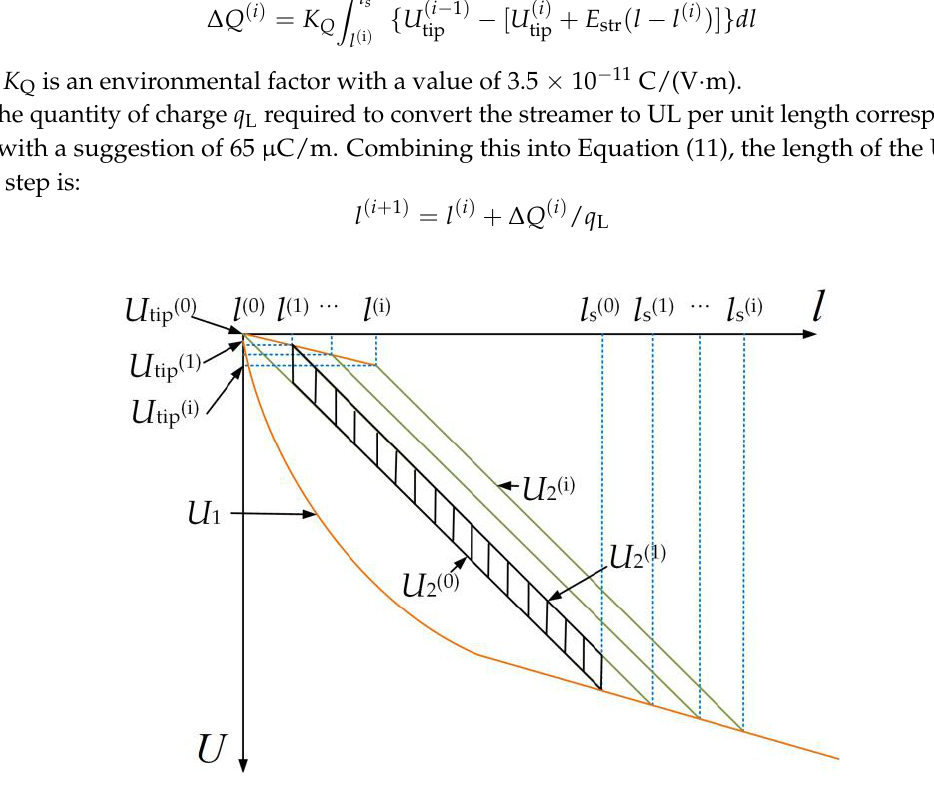
Figure 4. The progress of upward leader inception.